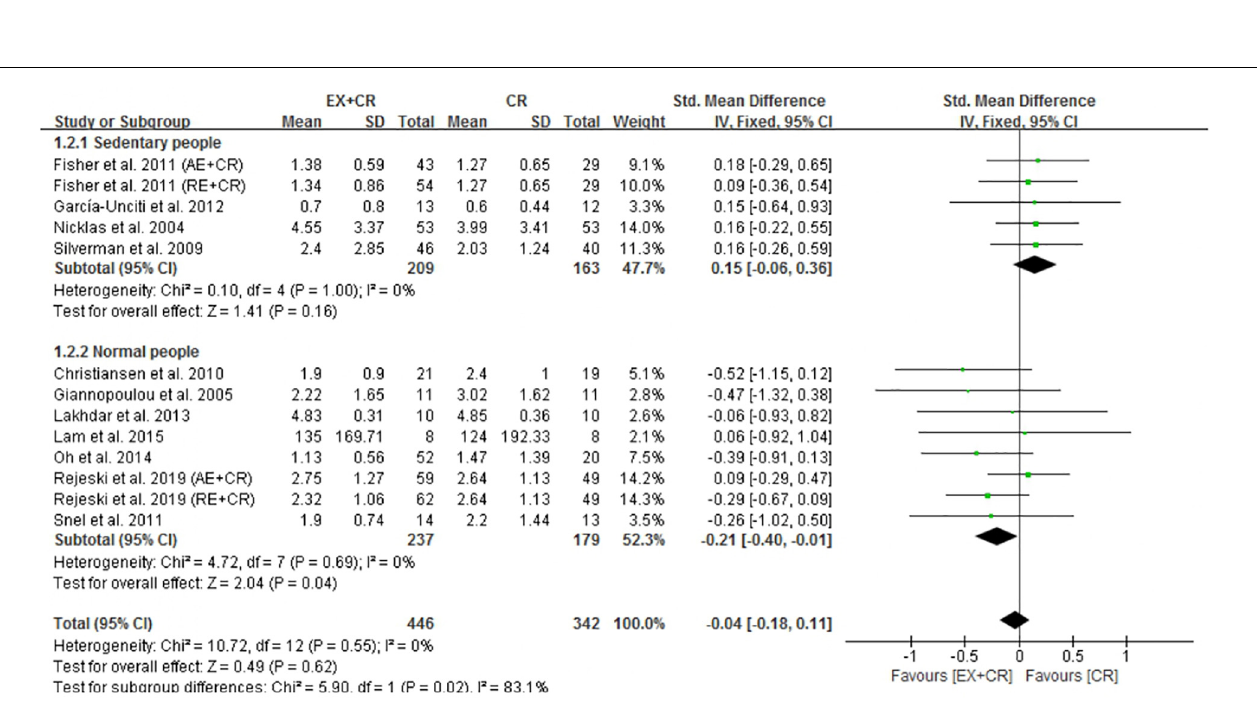
Frontiers in Physiology |